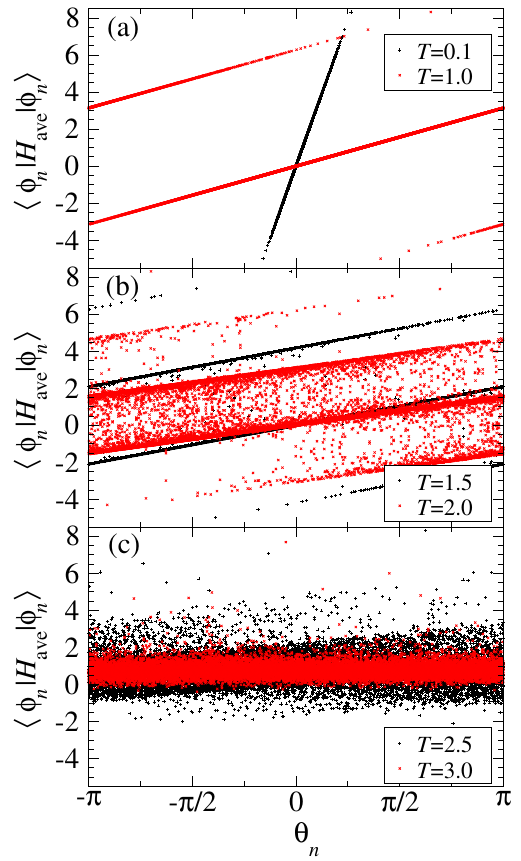
ˆ H ϕ n i vs the exact phases ave j